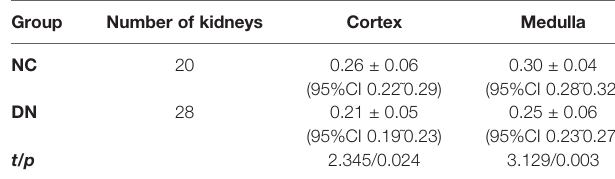
TABLE 2 | The ADC value of renal cortex and medulla (×10 -3 mm 2 /s). TABLE 3 | The FA value of renal cortex and